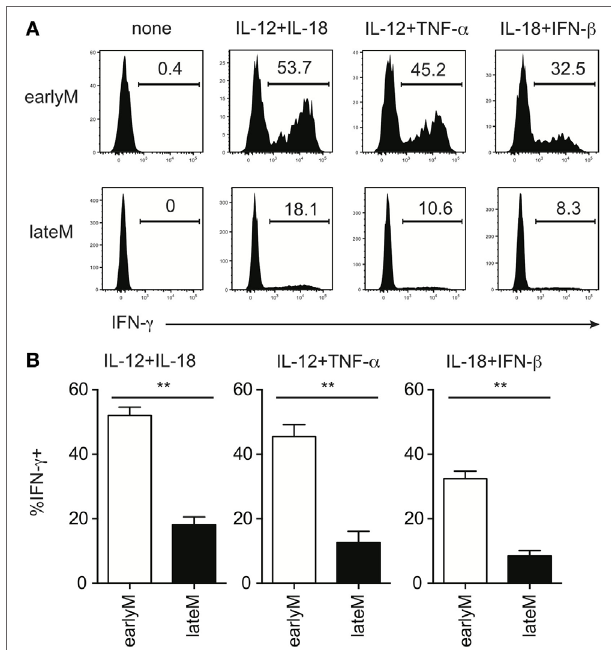
FigUre 2 | Memory CD8 T cell IFN- γ production in response to inflammatory cytokines decreases with time after initial antigen encounter. Mice received adoptive transfer of naïve P14 cells and were infected with LCMV-Armstrong. Either 30 days (earlyM) or > 8 months (lateM) after LCMV infection, splenocytes were harvested; mixed together; and incubated for 4 h with 10 ng/mL each of rIL-12 and IL-18, IL-12 and TNF- α , or IL-18 and IFN- β in the absence of Brefeldin A and for 1 additional hour in the presence of Brefeldin A. (a) Representative histograms of IFN- γ production by earlyM (top) or lateM (bottom) P14 cells incubated with the indicated combinations of inflammatory cytokines. (B) Summary bar graphs of the percentage of earlyM or lateM P14 cells producing IFN- γ following incubation with the indicated combinations of inflammatory cytokines. n = 3 mice/group. Representative data from 1 of > 3 independent experiments. Error bars represent mean ± SEM. Unpaired t -test; ** p <